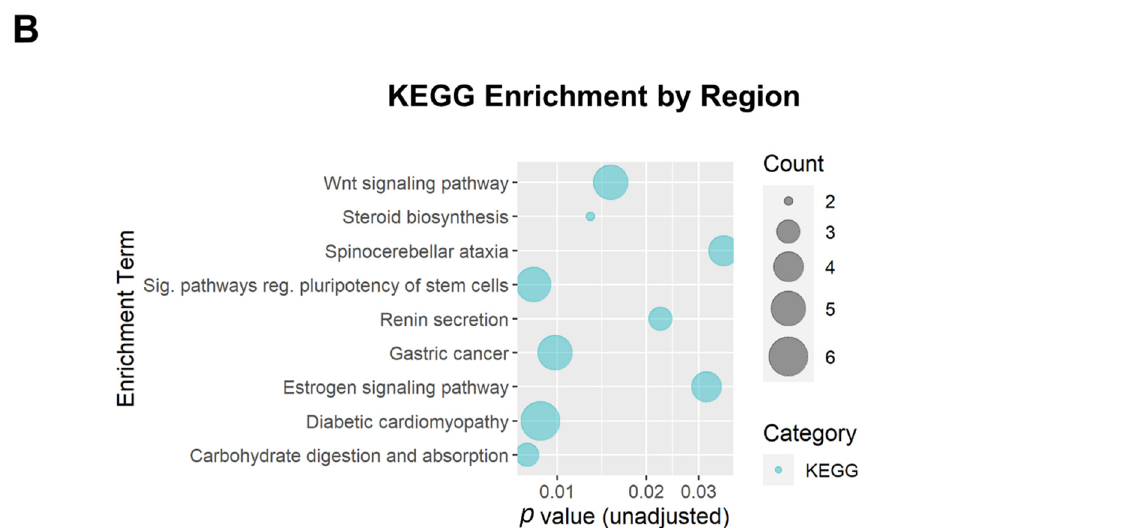
Figure 7. Bubble plots of gene enrichment results from the top differentially methylated regions associated with opioid exposure. A total of 199 DMRs (minimum smoothed FDR < 0.05) mapped to 174 genes that were used as input for the enrichment analysis. ( A ) The top 15 Gene Ontology (GO) enrichment terms. GO terms are color-coded by subcategory (Biological Process, Molecular Function, or Cellular Component). All unadjusted p ≤ 0.007. ( B ) The top 9 Kyoto Encyclopedia of Genes and Genomes (KEGG) enrichment terms. The size of the bubble for each enrichment term corresponds to the number of enriched genes within that pathway.